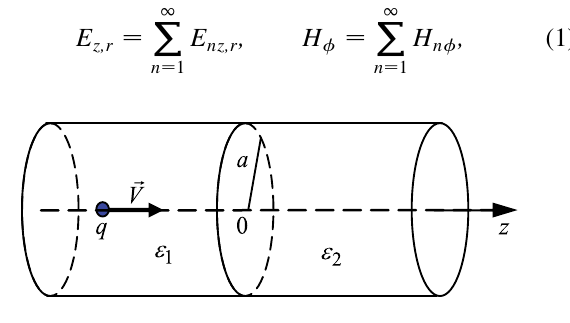
FIG. 1. Geometry of